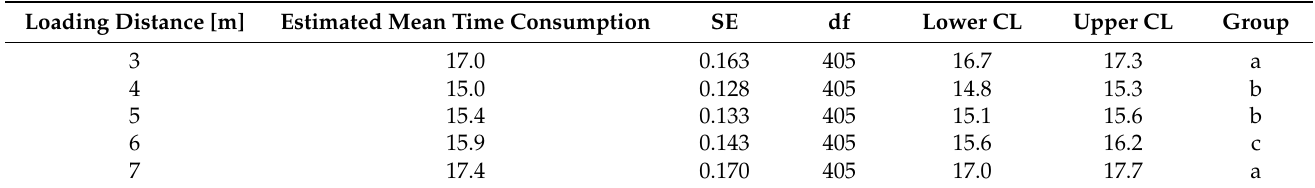
Table 5. Least-squares means of time consumption required for loading cycles of each loading